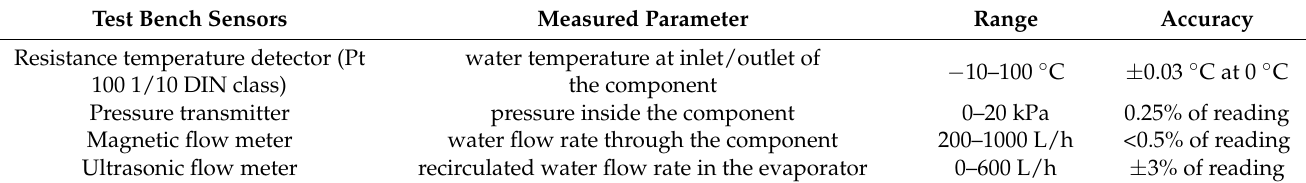
Table 2. Sensors’ range and